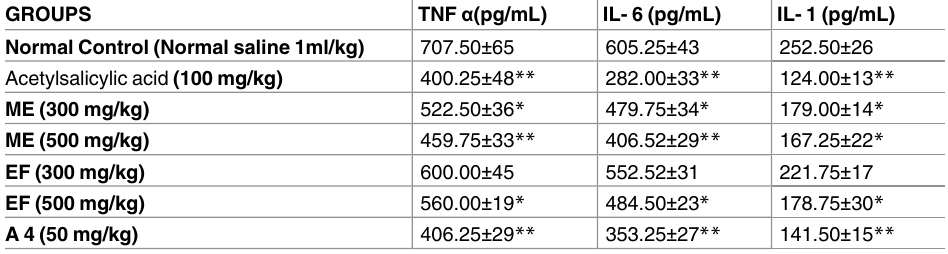
Table 2. Effects of M . philippensis on serum